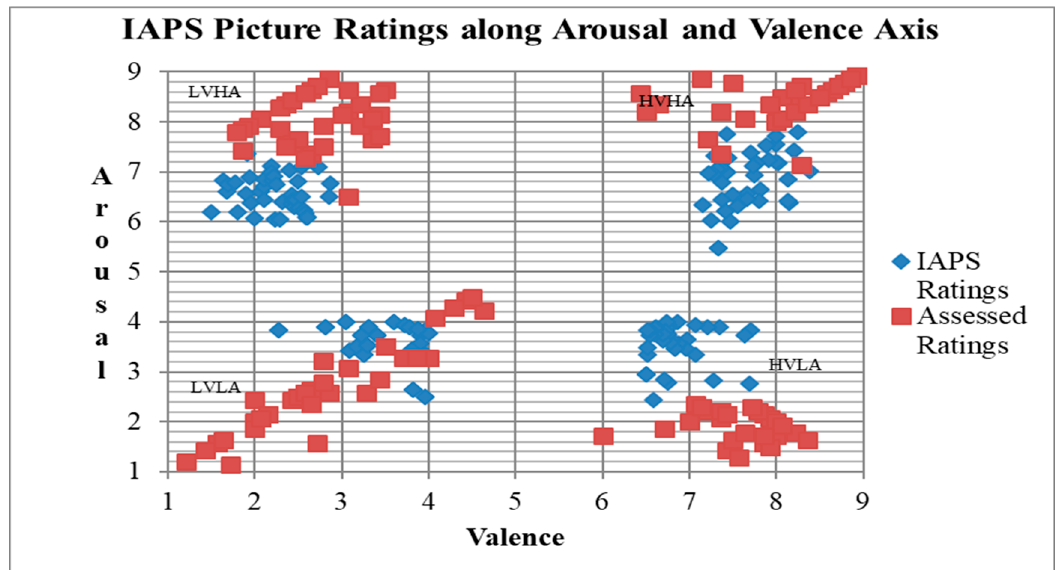
Figure 4. IAPS and assessed mean ratings on arousal and valence scale.